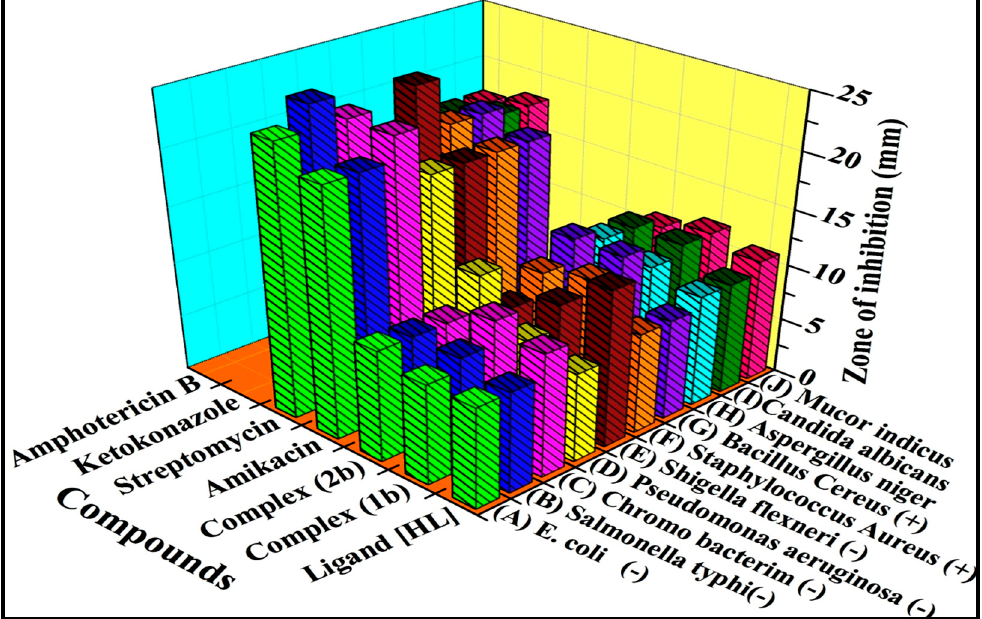
Figure 12. Histogram showing the comparative antimicrobial activities of ligand ( HL ) and its mixed ligand complexes ( 1b – 2b ) by Agar disc diffusion method.